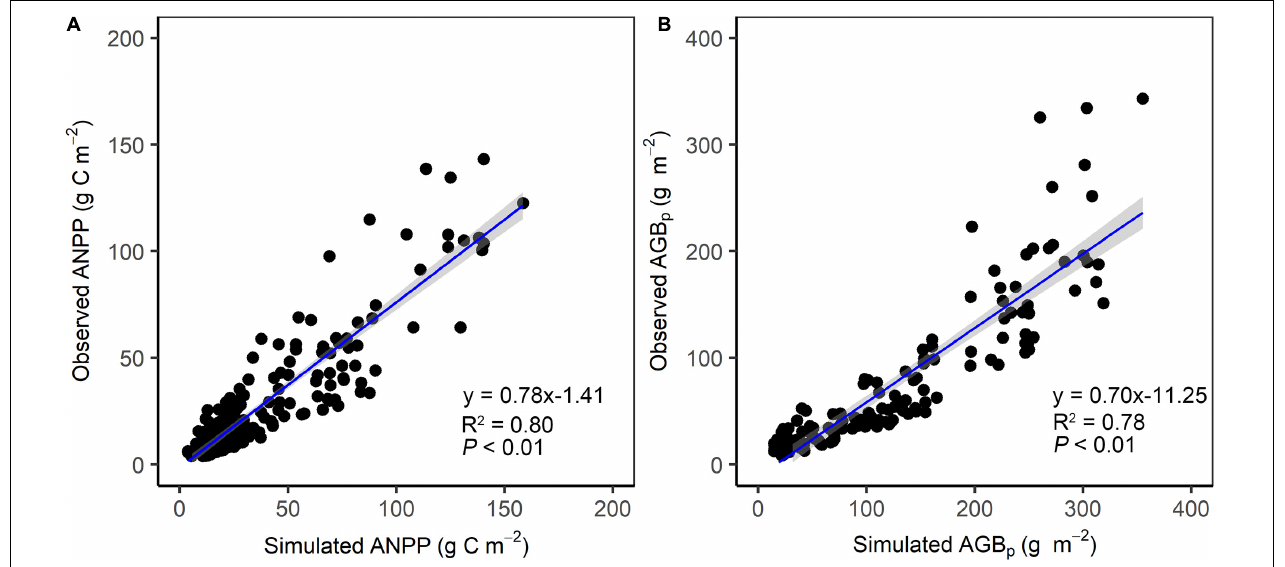
FIGURE 2 | Comparisons (A) between simulated and observed ANPP and (B) between simulated and observed AGB p .